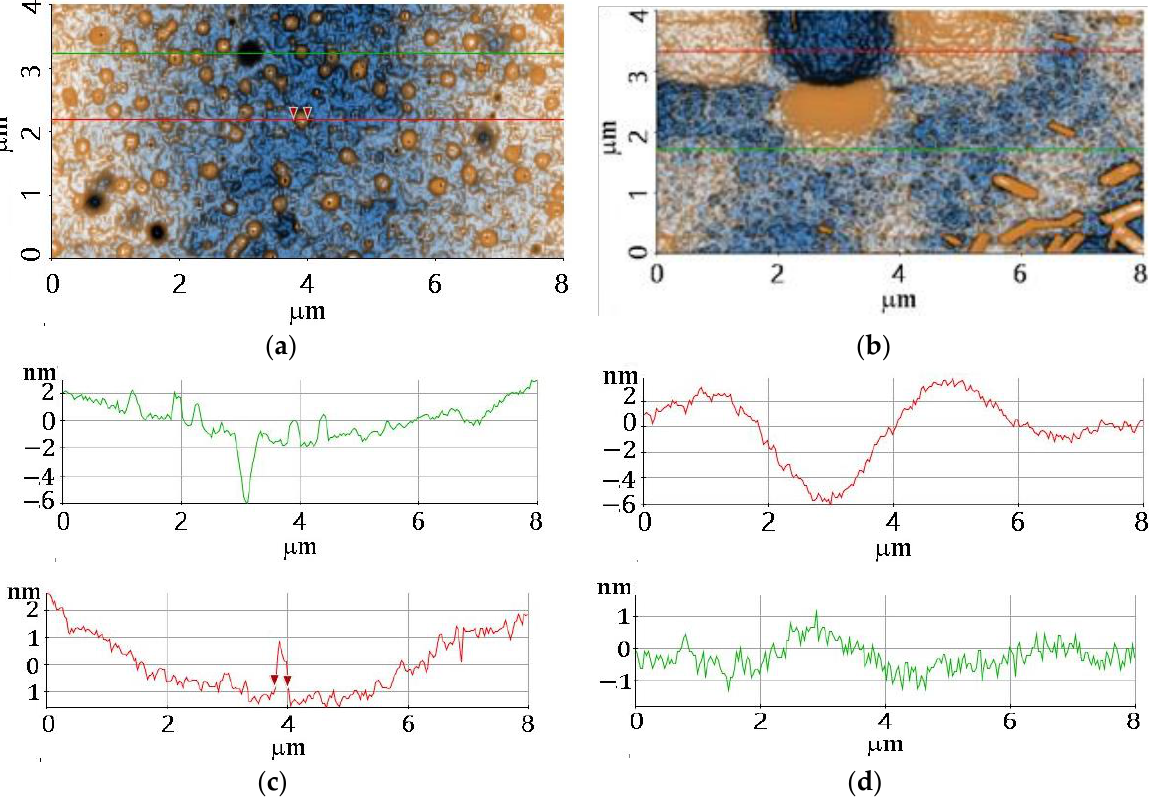
Figure 5. 2D AFM images (enhanced contrast) scanned over 4 µm × 8 µm, together with two representative line scans collected along the X-axis (the positions are indicated in each AFM figure) for fluorinated hybrid coatings: sample F1 ( a , c ) and sample F2 ( b , d ). Figure 6 exhibits the morphology of samples F1 and F2, deposited on glass substrates. 2 µ m × 2 µ